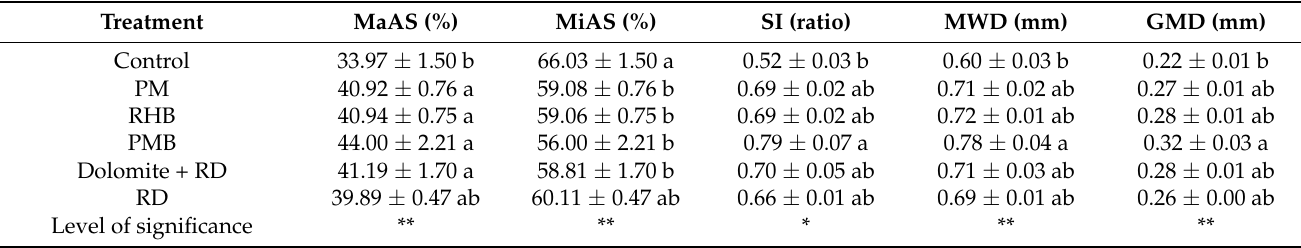
Figure 1. Distribution of different aggregate size fractions within 0–15 cm soil layer under different treatments in acidic soil (bars = average and line = standard error of mean, SEM; n = 10). (PM = poultry manure, RHB = rice husk biochar, PMB = poultry manure biochar, RD = recommended dose from only chemical fertilizer). Table 3. Effects of different treatments on soil aggregate properties of acidic